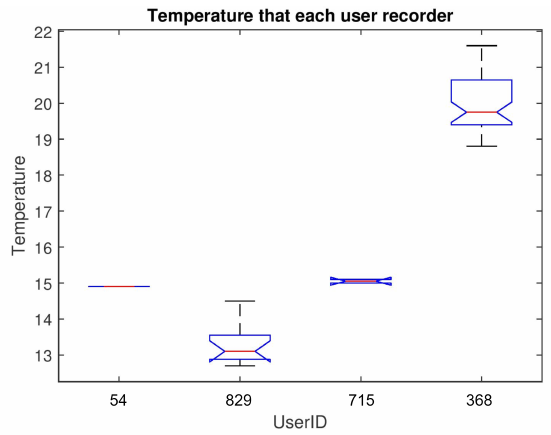
Figure 11. Intra-cluster data grouped by user